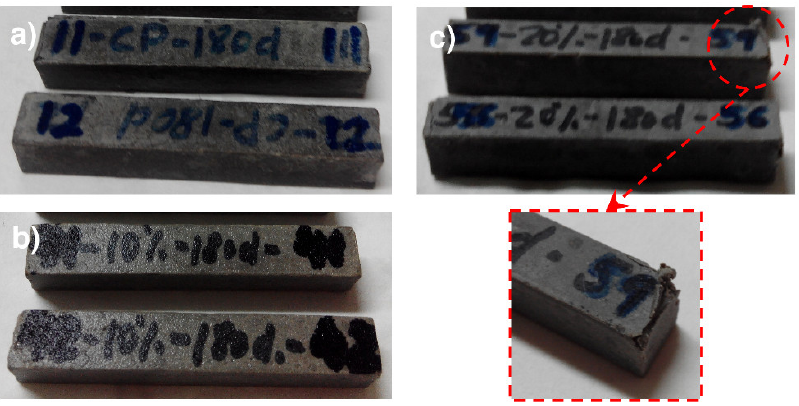
Figure 4. 180 days Na 2 SO 4 -soaked specimens: ( a ) OPC; ( b ) OPC + 10GS; and, ( c ) OPC + 20GS.